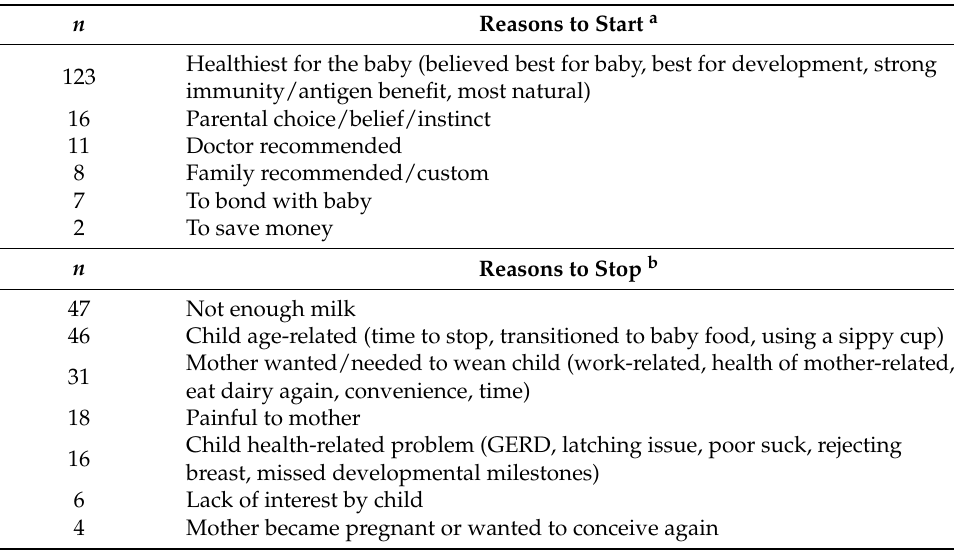
Table 7. Reasons children with FXS were fed breast milk or stopped being fed breast milk.